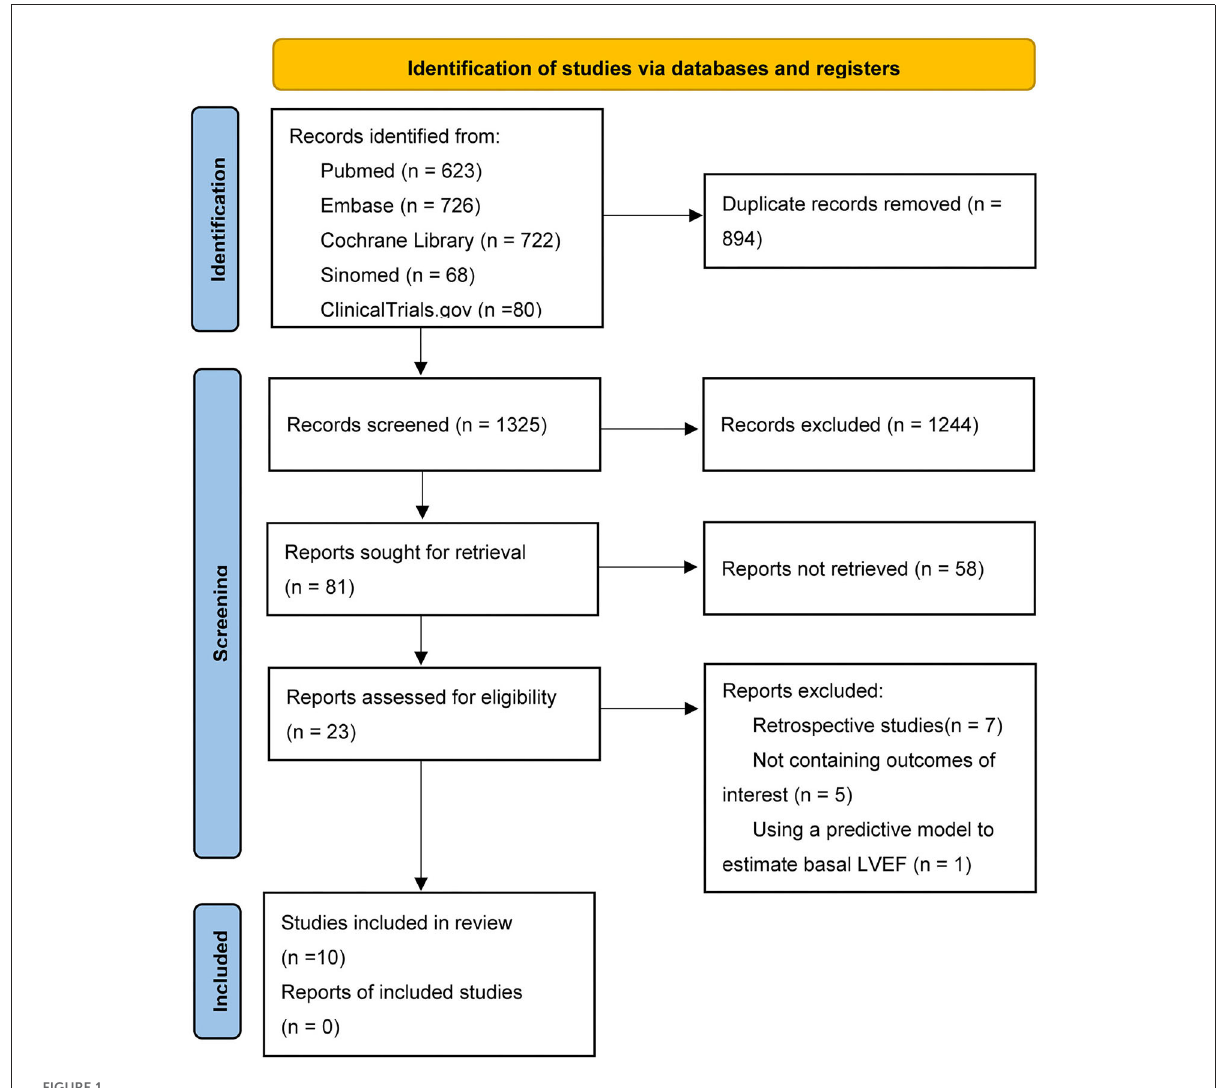
FIGURE1 PRISMA flowchart of